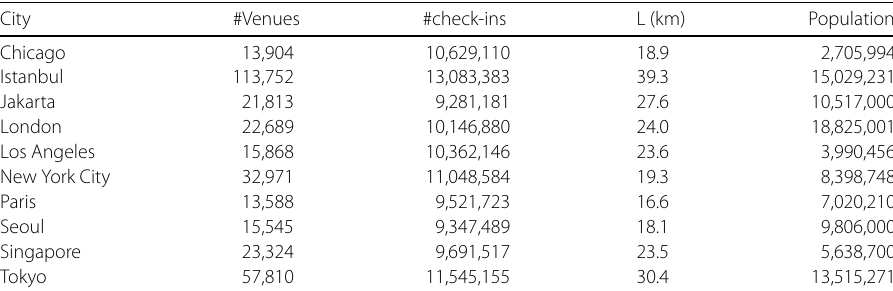
Table 1 Foursquare data set extensive characteristics. The figures here are aggregated for all layers and comprise all 24 months. The linear size L is here estimated as the square root of the total area covered by the data after the aggregation into squares of 500 m × 500 m. Please note that the value of population for the city of Paris here corresponds to the Grand Paris Metropolitan areas that is the territory roughly covered by the data. Other population correspond to the municipality area (or the national area for the case of Singapore) City #Venues #check-ins L (km) Population Chicago